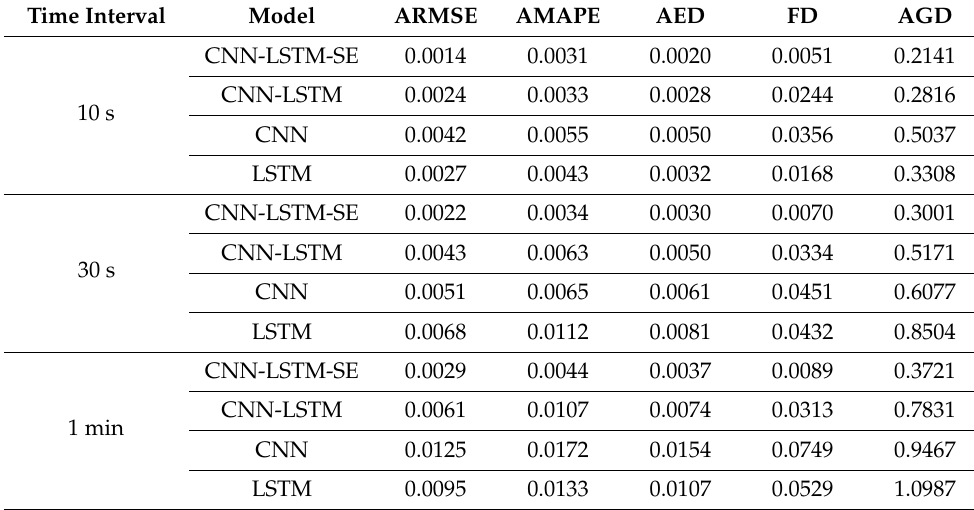
Table 2. Trajectory prediction results of